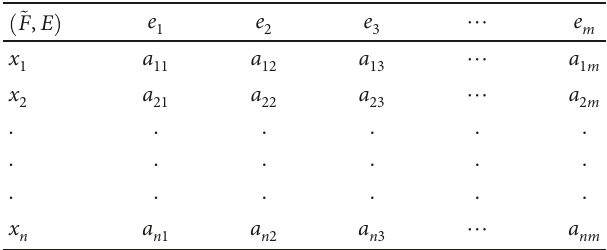
Algorithm 1 (decision-making based on fuzzy soft sets). Table 2: Fuzzy soft set F , E .